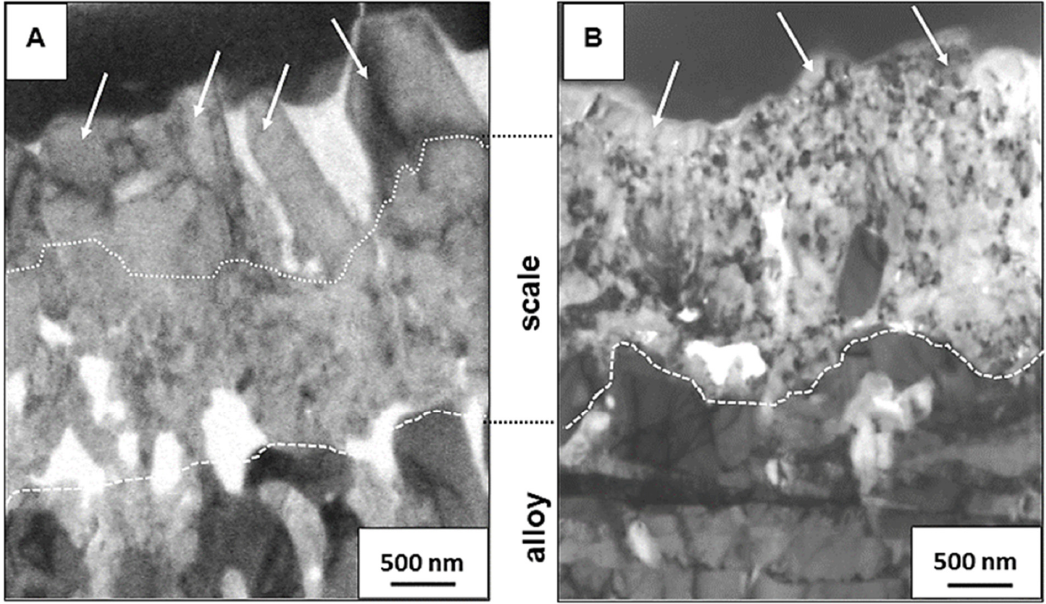
Figure 5. Through-scale microstructure of the 718Plus superalloy after oxidation at 850 ◦ C for 120 h in dry ( A ) and wet ( B ) air; TEM-BF images.